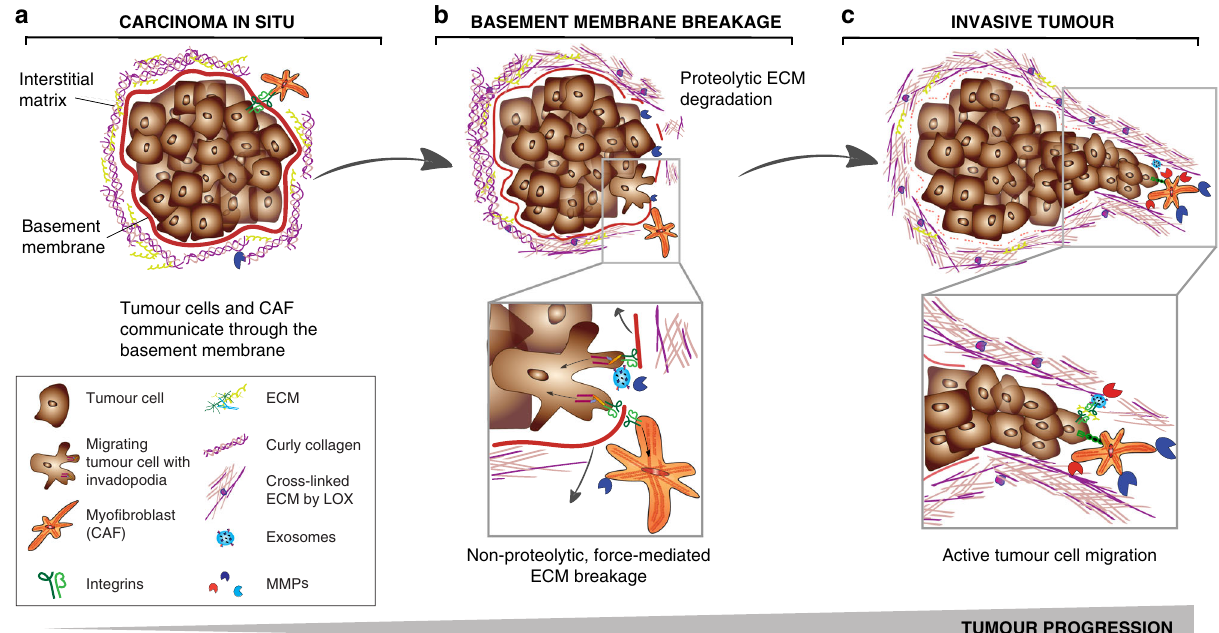
Fig. 3 ECM remodelling during tumour cell migration. a In carcinoma in situ, tumour cells are restricted from migrating and invading into the surrounding tissue by the intact basement membrane. Tumour cells and stroma cells may be physically connected through the basement membrane using integrins. ECM in the interstitial matrix is curly. b Basement membrane breakage can be achieved through proteolytic ECM degradation by proteases secreted by tumour cells and activated stroma cells (top) and through non-proteolytic, force-mediated ECM remodelling (lower box). Integrins expressed on invadopodia, an invasive actin-rich cell structure on tumour and cancer-associated fi broblasts (CAFs), bind to ECM molecules and couple them intracellularly to contractile structures. This process pulls the ECM molecules apart and applies force to the basement membrane facilitating non- proteolytic basement membrane breaching. c In invasive tumours, the basement membrane is mostly degraded. CAFs and tumour cells secrete LOX to cross-link collagen fi bres. Increased cross-linking and force-mediated ECM remodelling creates linearised ECM in the tumour-surrounding interstitial matrix. Tumour cells migrate along regions with dense, aligned collagen fi bres forming migratory tracks for ef fi cient cell migration. (lower box) Membrane- bound proteases expressed on tumour cells and CAFs, such as MT1-MMP localised on invadopodia, degrades the collagen migration barriers. Exosomes contain additional proteases to clear the ECM for tumour cell migration and are released into the interstitial matrix. Integrins on the surface of secreted exosomes bind to fi bronectin, which functions as a bridging molecule connecting integrins expressed on tumour cells thereby promoting the formation of invadopodia and tumour cell migration. CAFs can function as leader cells for directed tumour cell migration and are connected to tumour cells through E- cadherin/N-cadherin